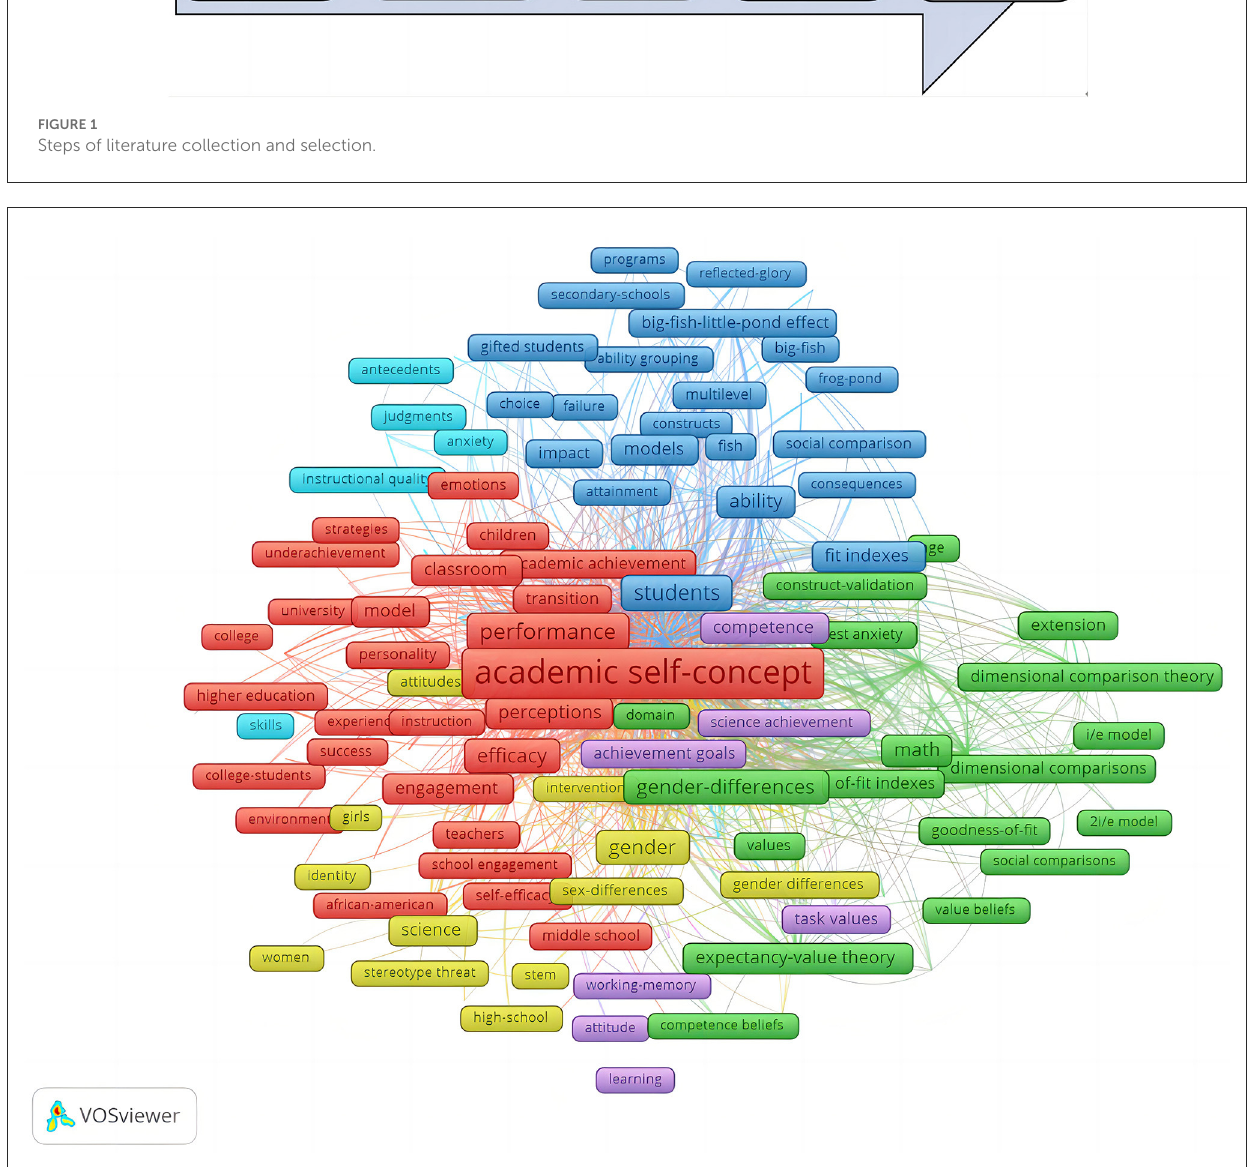
FIGURE2 The bibliographic